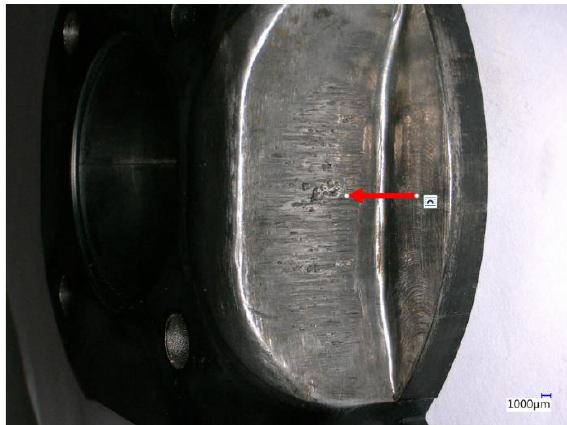
Figure 1. Fractured surface of casting mold.